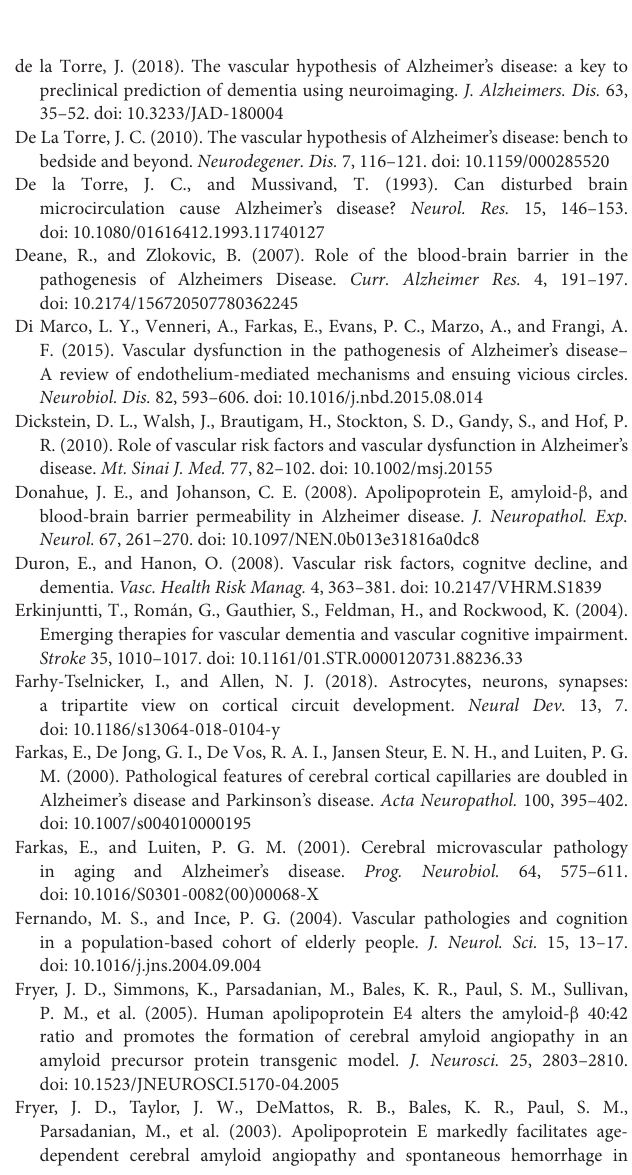
Supplementary Table 1 | List of significantly regulated proteins in the cerebrovasculature of the inferior frontal gyrus of young vs. aged control cases. Data are expressed as the negative Log10 of the p -value (green horizontal bars–significance cut off set at > 1.3), and the Log2 fold change between young vs. aged control cases. Heat map indicates downregulated (Red box) or upregulated (Blue box) proteins. Statistical analyses was performed using t-test after logarithmic transformation. Red text highlights indicate 124 significantly proteins identified that were unique to only this comparison in our entire study . Supplementary Table 2 | List of significantly regulated proteins in the cerebrovasculature of the inferior frontal gyrus of low CAA + Alzheimer’s disease and aged-matched control cases. Data are expressed as the negative Log10 of the p -value (green horizontal bars–significance cut off set at > 1.3), and the Log2 fold change between low CAA [AD] vs. age-matched control cases. Heat map indicates downregulated (Red box) or upregulated (Blue box) proteins. Statistical analyses was performed using t -test after logarithmic transformation. Red text highlights indicate 17 significantly proteins identified that were unique to only this comparison in our entire study .